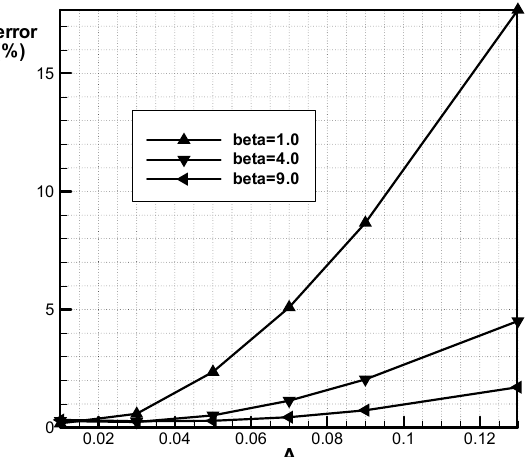
Fig.5 The relative error of the velocity at t=T/8 in Womersley flow at the middle the channel against various amplitudes of pressure gradients.